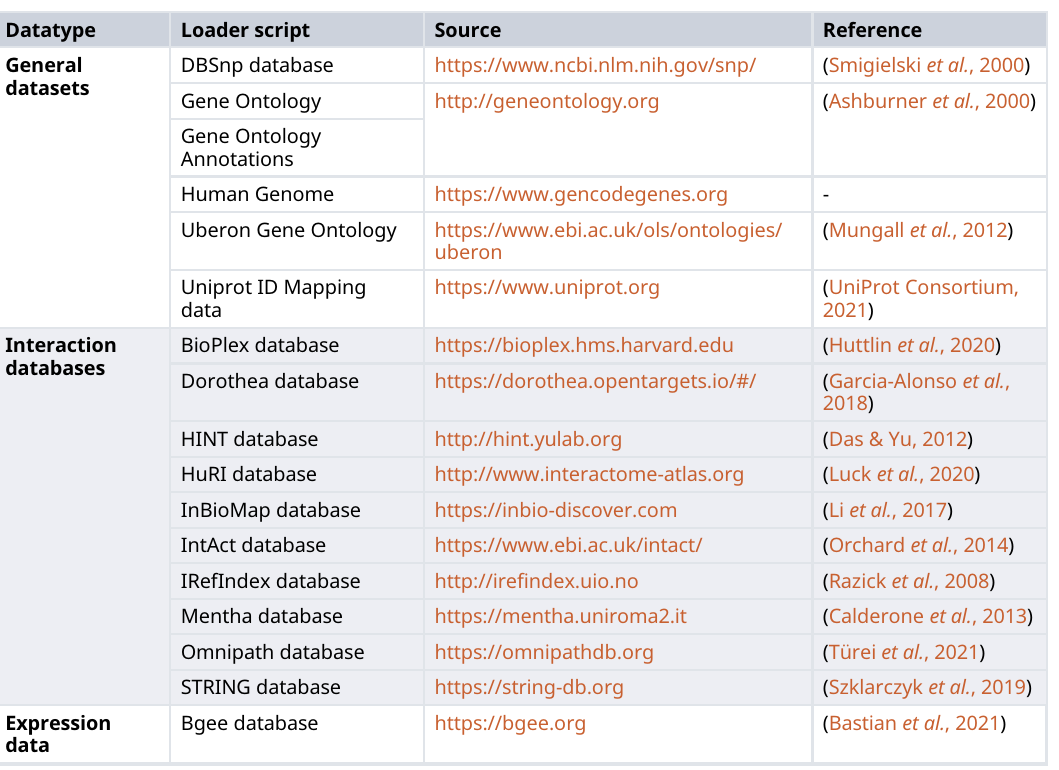
Table 1. The specific loader scripts, which are already included in Sherlock ’ s GitHub